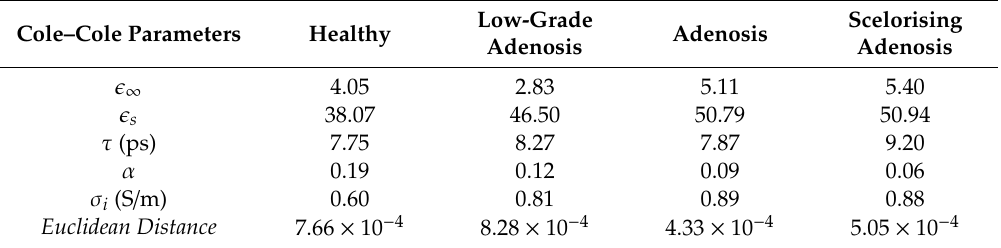
Figure 5. Comparison of the measured median dielectric properties and Cole–Cole fitting results: ( a ) Measured and Cole–Cole parameter relative permittivity values; ( b ) Measured and Cole–Cole parameter conductivity values. Table 5. One-pole Cole–Cole parameters fitted to the mean of the measured dielectric properties of healthy and benign rat mammary tissues.